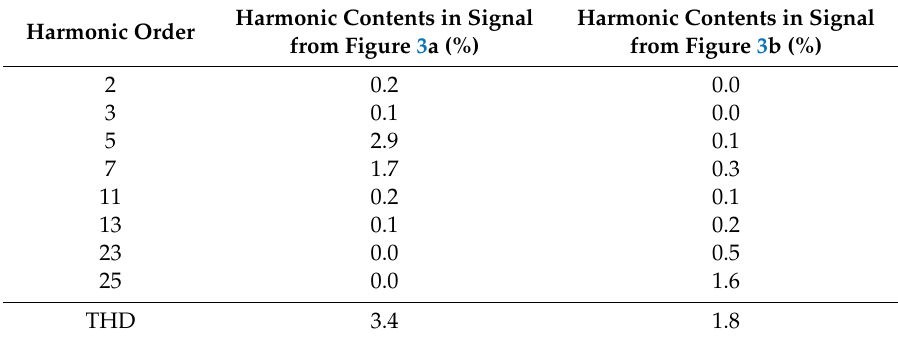
Figure 3. The voltage waveforms in (a) 220 V ferry network and (b) 400 V network supplied by a shaft generator on a ro-ro ship [3]. Table 2. Exemplary harmonic contents of analysed signals [3].